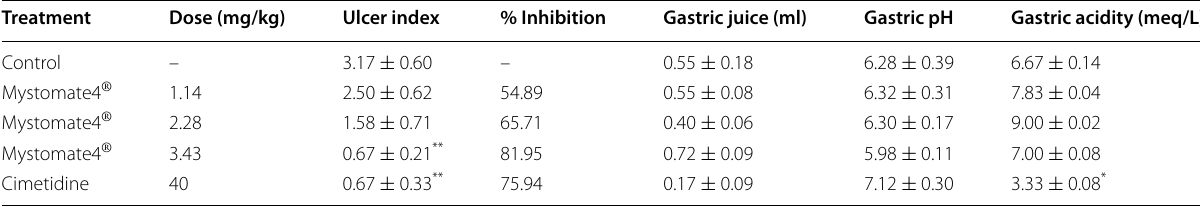
The results are expressed as mean